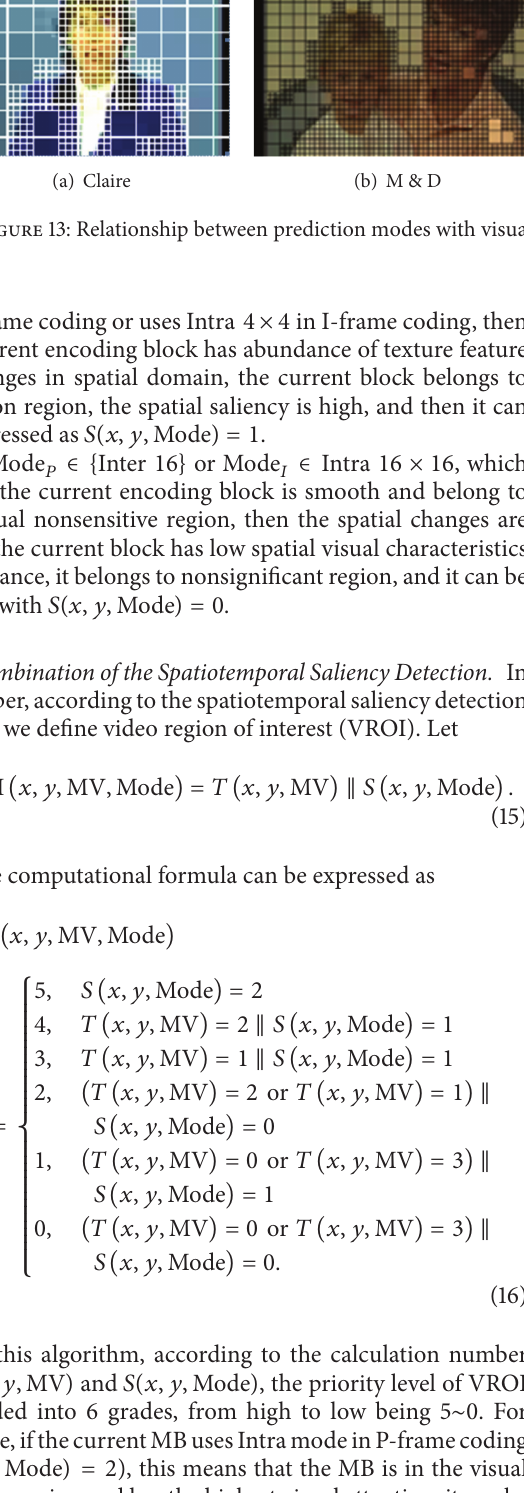
Figure 13: Relationship between prediction modes with visual attention. ((a), (b)) I frame encoding, ((c), (d)) P frame encoding.